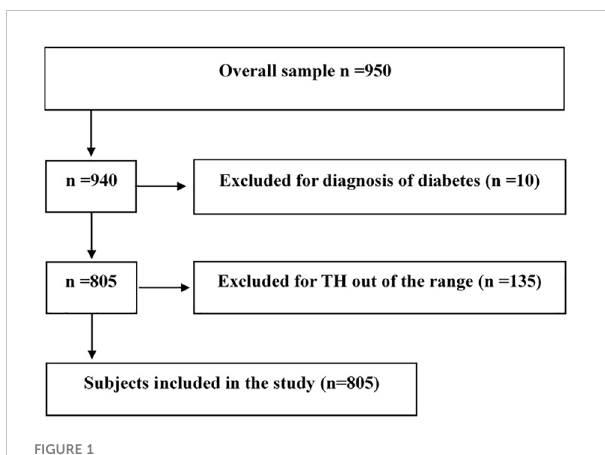
FIGURE 1 Flowchart of the selection of study participants. Thyroid hormones